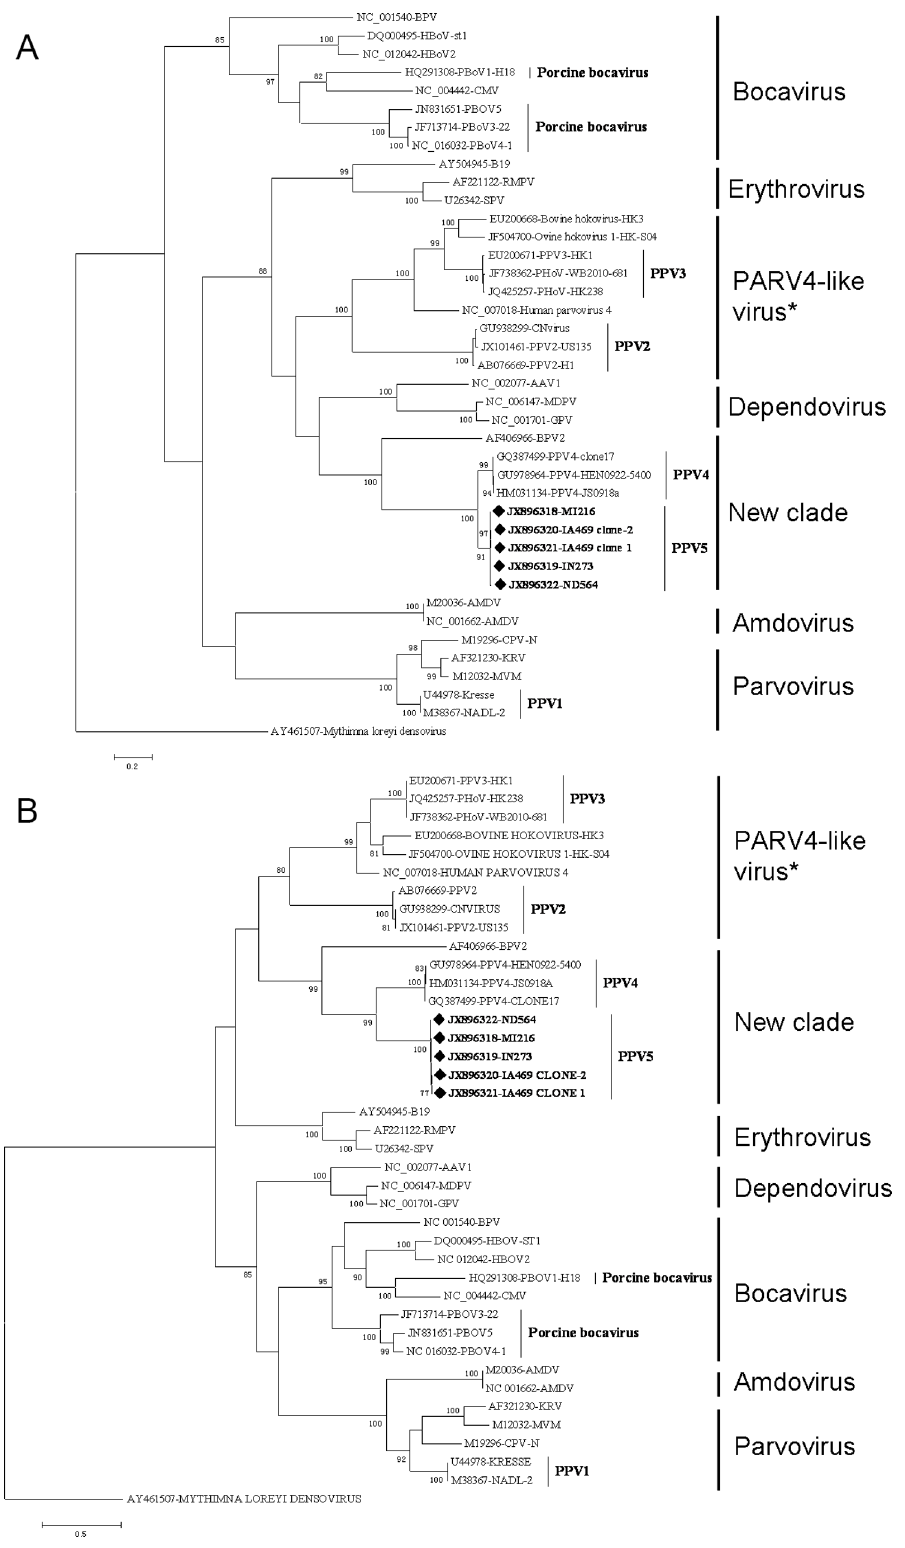
Figure 4. The phylogenetic trees were constructed by using the Maximum Likelihood method based on the Poisson correction model, with the amino acid sequences of the nonstructural protein (ORF1, NS1) and the capsid protein (ORF2, VP1). The percentage of the tree in which the associated sequences clustered together is shown above the branches (only . 70% are shown). The trees are drawn to scale, with branch lengths measured in the number of substitutions per site. Evolutionary analyses were conducted in MEGA5 [34]. The analyses involved 39 sequences of vertebrate parvoviruses with their GenBank accession numbers marked in the tree. PPV5 sequences characterized in the present study